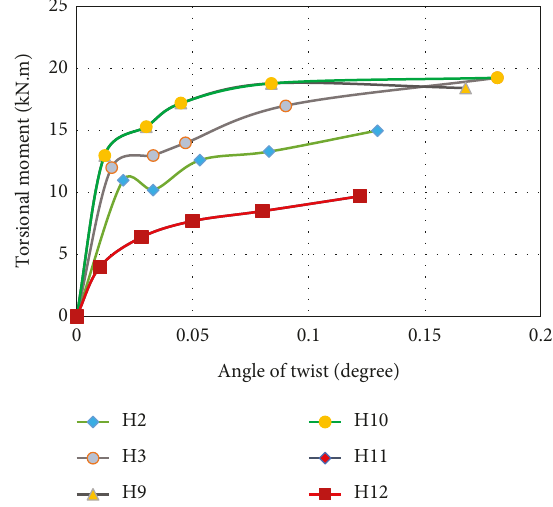
Figure 8: The twist angle and torque